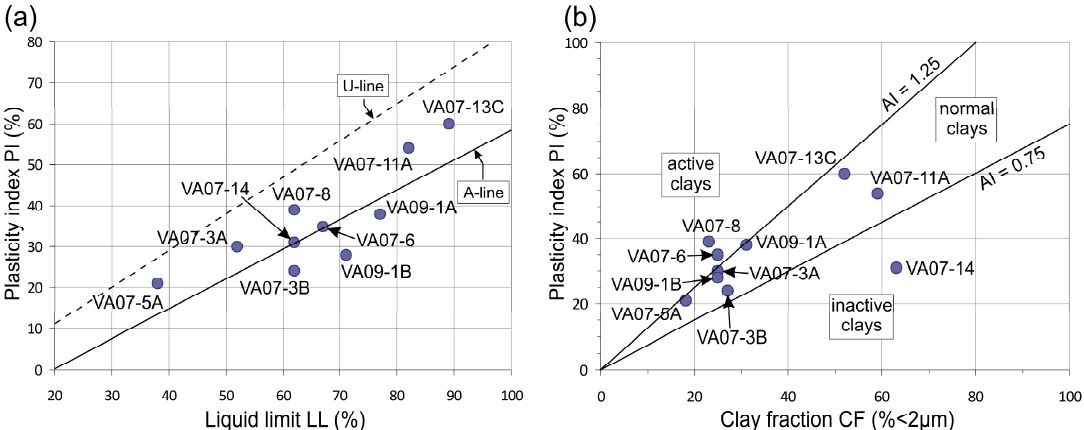
Figure 8. ( a ) Plasticity chart and ( b ) activity chart of the clay materials involved in the basal rupture of the 1963 Vajont landslide.